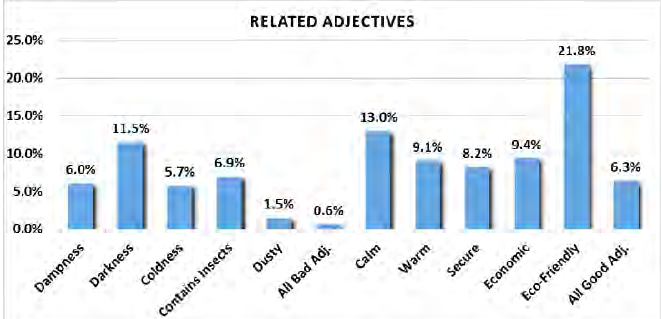
Figure 3. The sample adjectives’ selection about adjectives related with the“Earth-sheltered”